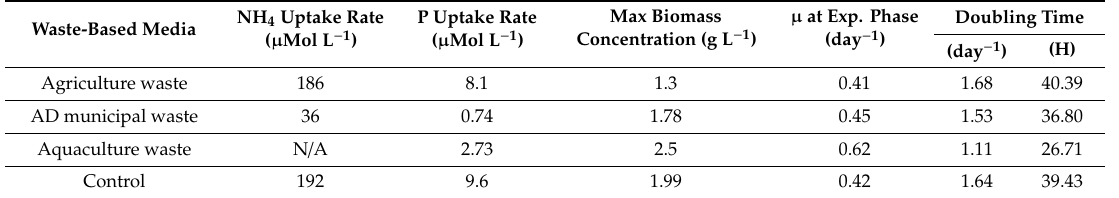
Table 3. Summary of growth and nutrients uptake parameters of N. oceanica grown on three waste-based media. Waste-Based